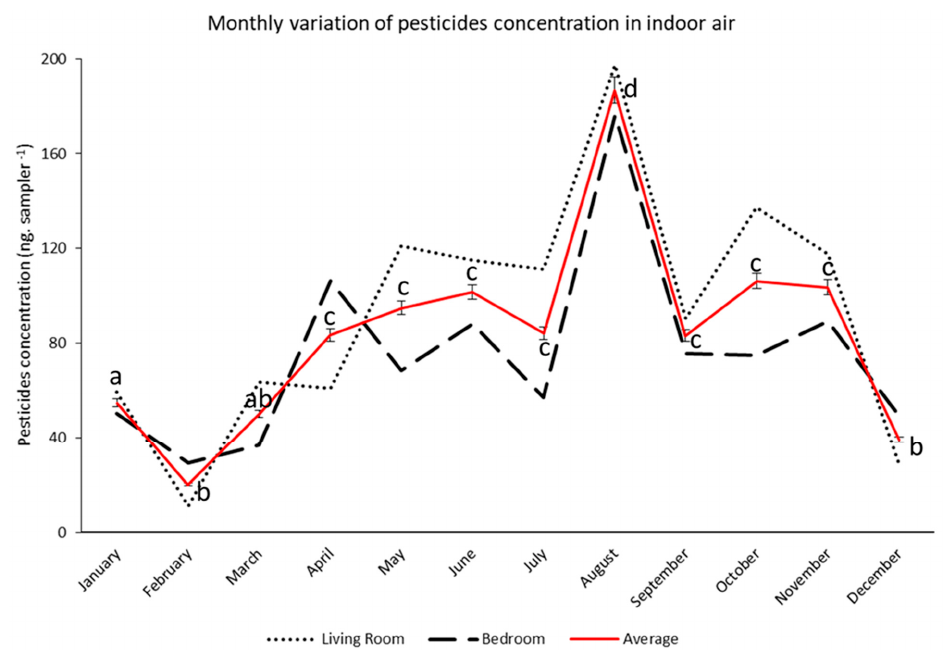
Figure 5. Monthly variations of the concentration of pesticides detected in the air samples collected from the living rooms and bedrooms of the nine targeted houses during the one-year sampling campaign (data are shown as per average concentration of pesticides detected in the nine residences per month). Differing lowercase denotes the means of averages that are significantly different ( p < 0.05) between each month .